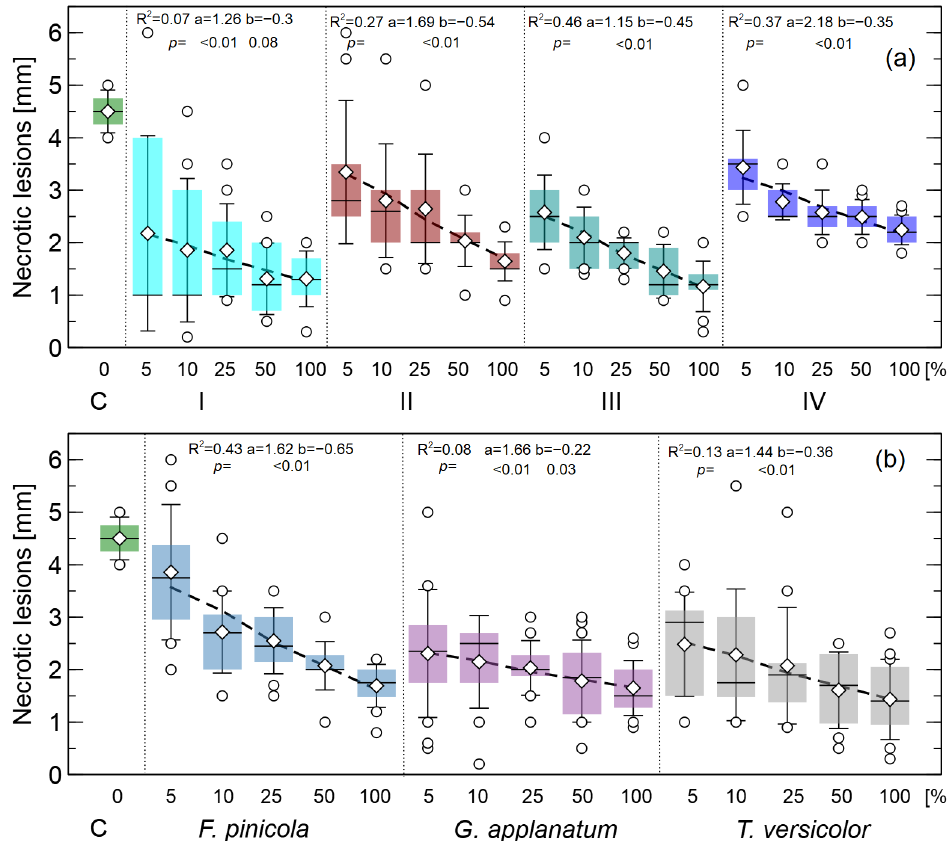
Figure 4. The relation between necrosis length and extract concentration in the control (C) and extract treatments. Comparison of ( a ) treatments with various extract application, and ( b ) various types of extracts. The dashed lines represent fitted regression lines y = a + b · ln ( x ) . The R 2 of the models, regression coefficients and corresponding p -values are typed in subfigures.